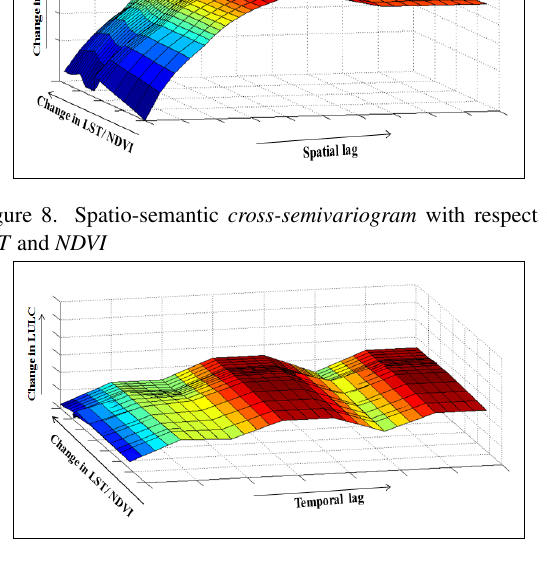
Figure 9. Temporal-semantic cross-semivariogram with respect to LST and